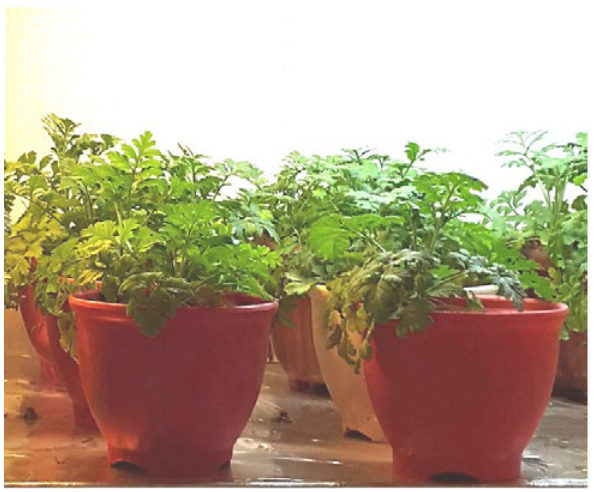
Fig. 1. The grown plants in pots in green house under controlled